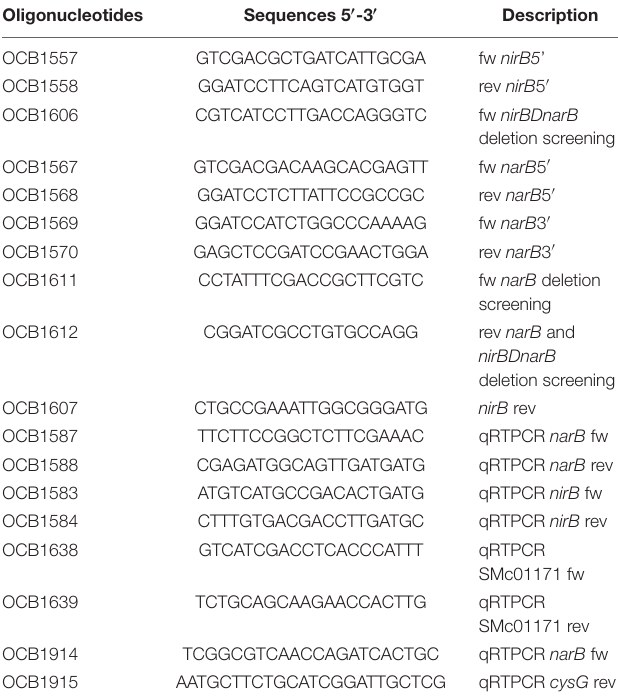
TABLE 2 | List of oligonucleotides. Oligonucleotides Sequences 5 (cid:48) -3 (cid:48)